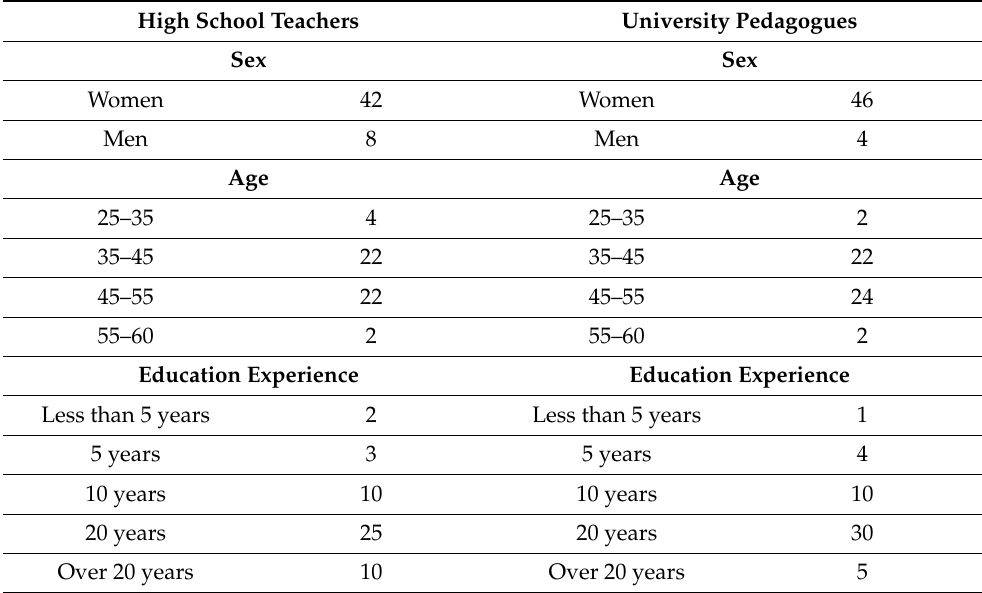
Table 1. Teachers’ and pedagogues’ characteristics: age, sex,